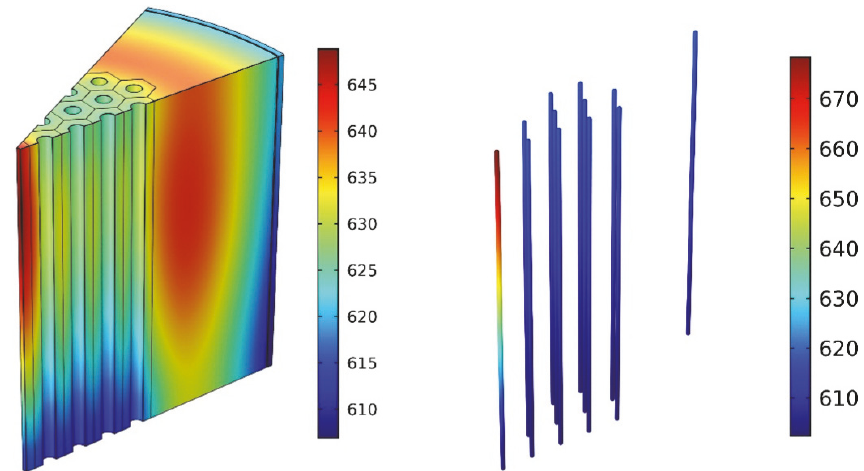
Figure 11: Temperature distribution in graphite (left) and fuel salt (right) (unit: ∘ C).